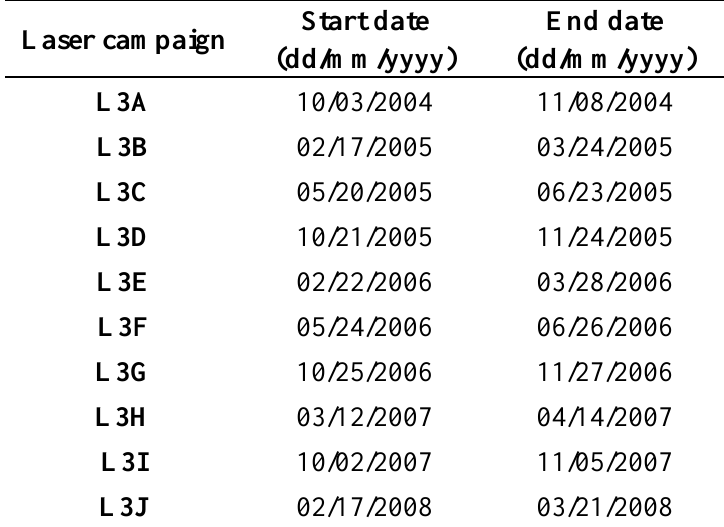
Table 2. Start date and End date of ICESat campaigns L3A to